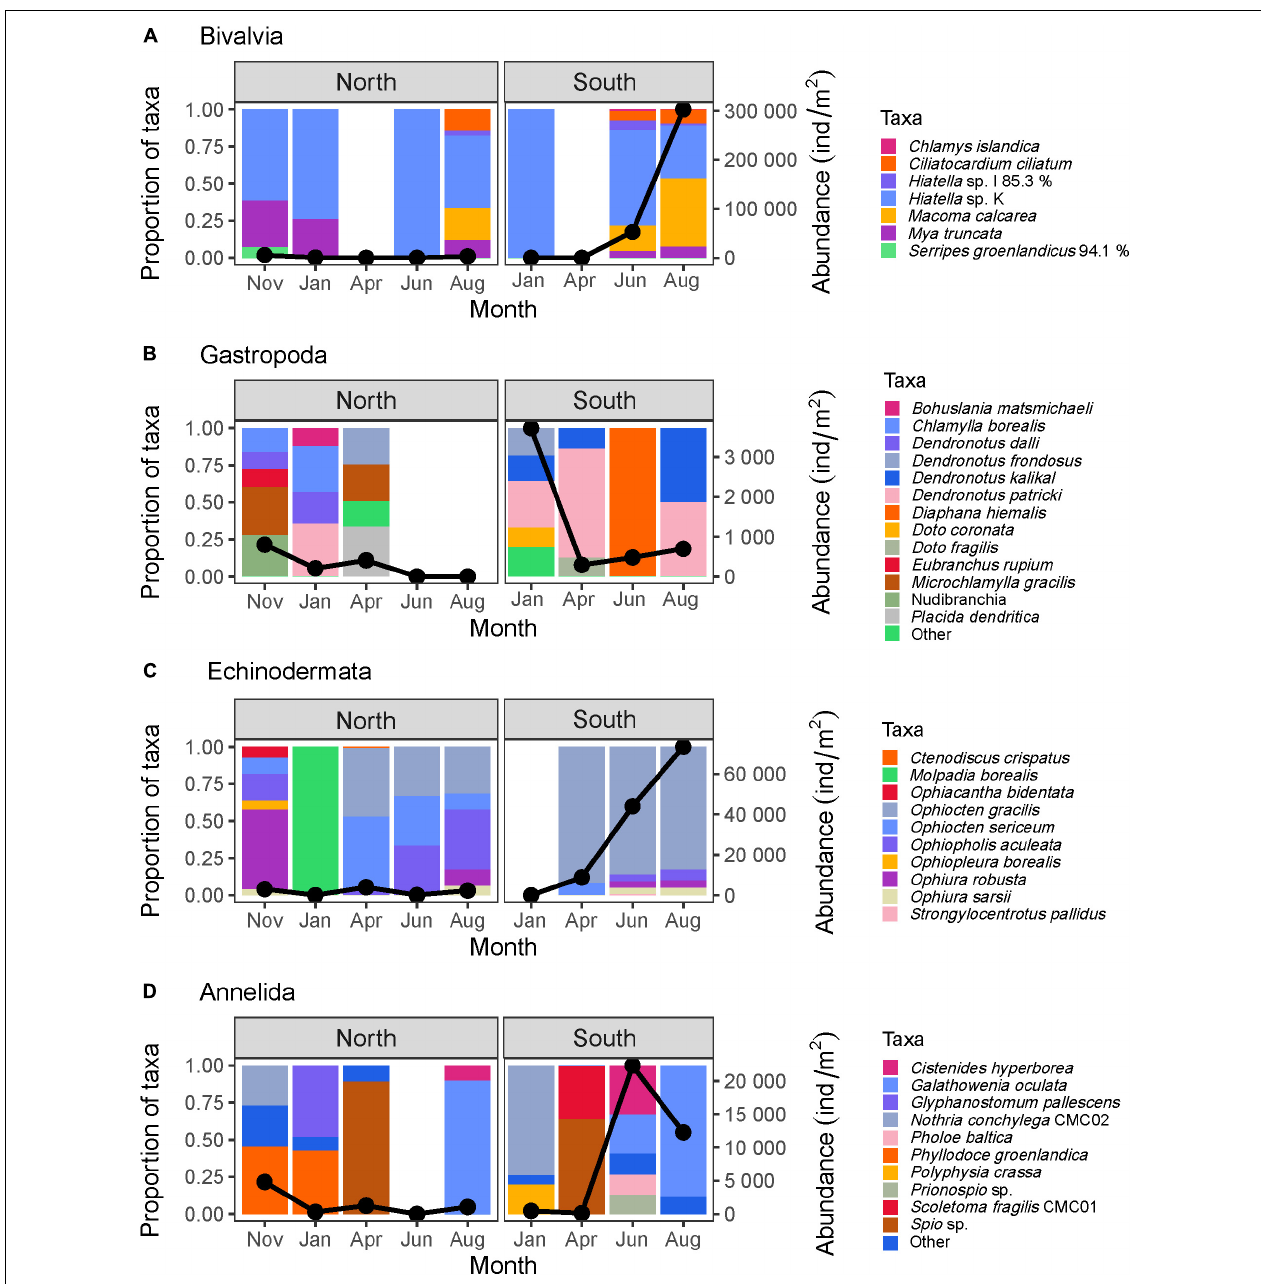
FIGURE 5 | Composition of the four most abundant meroplanktonic higher taxa: (A) Bivalvia, (B) Gastropoda, (C) Echinodermata, and (D) Annelida expressed as proportional abundance (colored bars, left y-axis) as well as total abundance (black line, right y-axis) for the locations north and south of the Polar Front. For Gastropoda and Annelida, taxa that did not make up at least 10% of the group’s abundance for at least one sampling point were combined in a “Other” category for ease of reading. Some taxa are named with letters or numbers instead of a species name (e.g., Hiatella sp. K and N. conchylega CMC02). These represent currently un-named but genetically-distinct